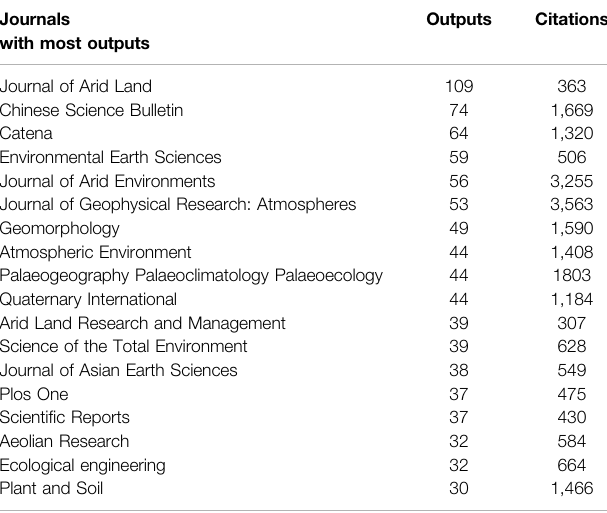
Outputs Citations